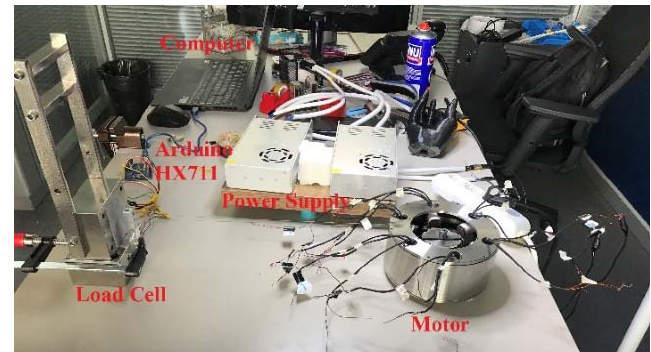
Figure 16. The gaussmeter device and the motor for the measurements of magnetic flux density.